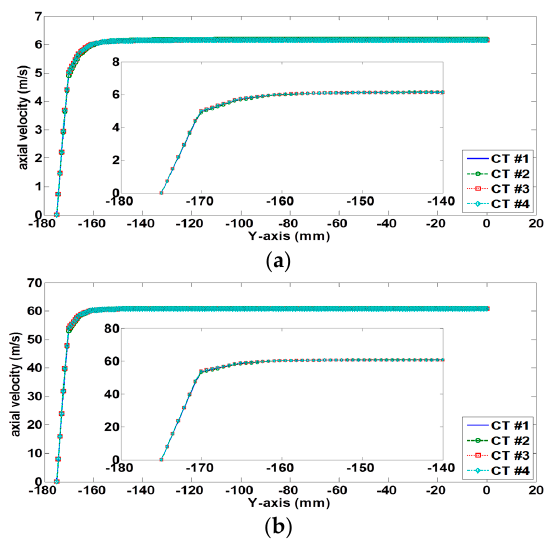
Figure 9. Axial velocity profiles at the square cross-sectional contraction exits, ( a ) V ex = 6 m/s; ( b ) V ex = 60 m/s.